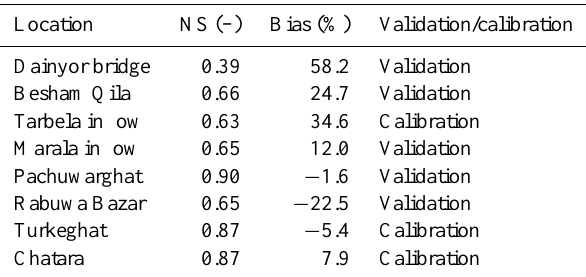
Table 3. Station locations used for calibration and validation of the SPHY model in HICAP (Lutz et al., 2014a). Three stations were used for calibration for 1998–2007. Five stations were used for an independent validation for the same period. The Nash–Sutcliffe ef- ficiency (NS) and bias metrics were calculated at a monthly time step.